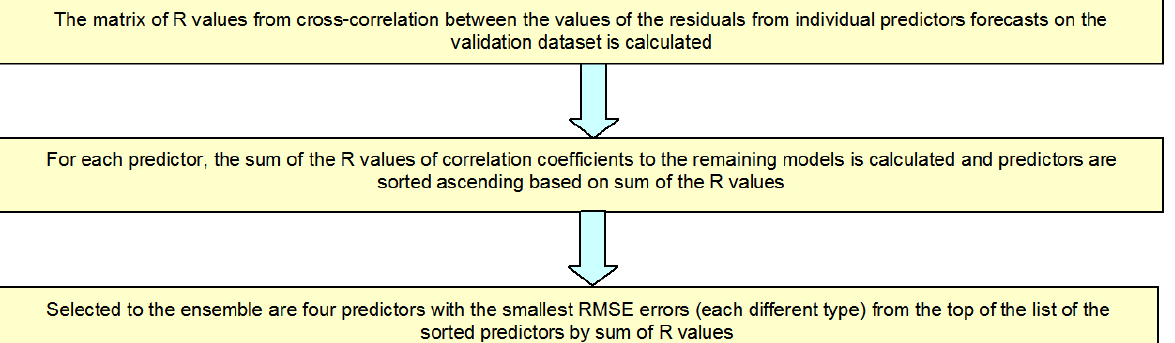
Figure 10. Algorithm of selection of predictors to the ensemble based on RMSE and R. Machine Learning (ML) as an Integrator of Ensemble . This is an integration of the results of the selected predictors into final verdict of the ensemble using ML model. Four